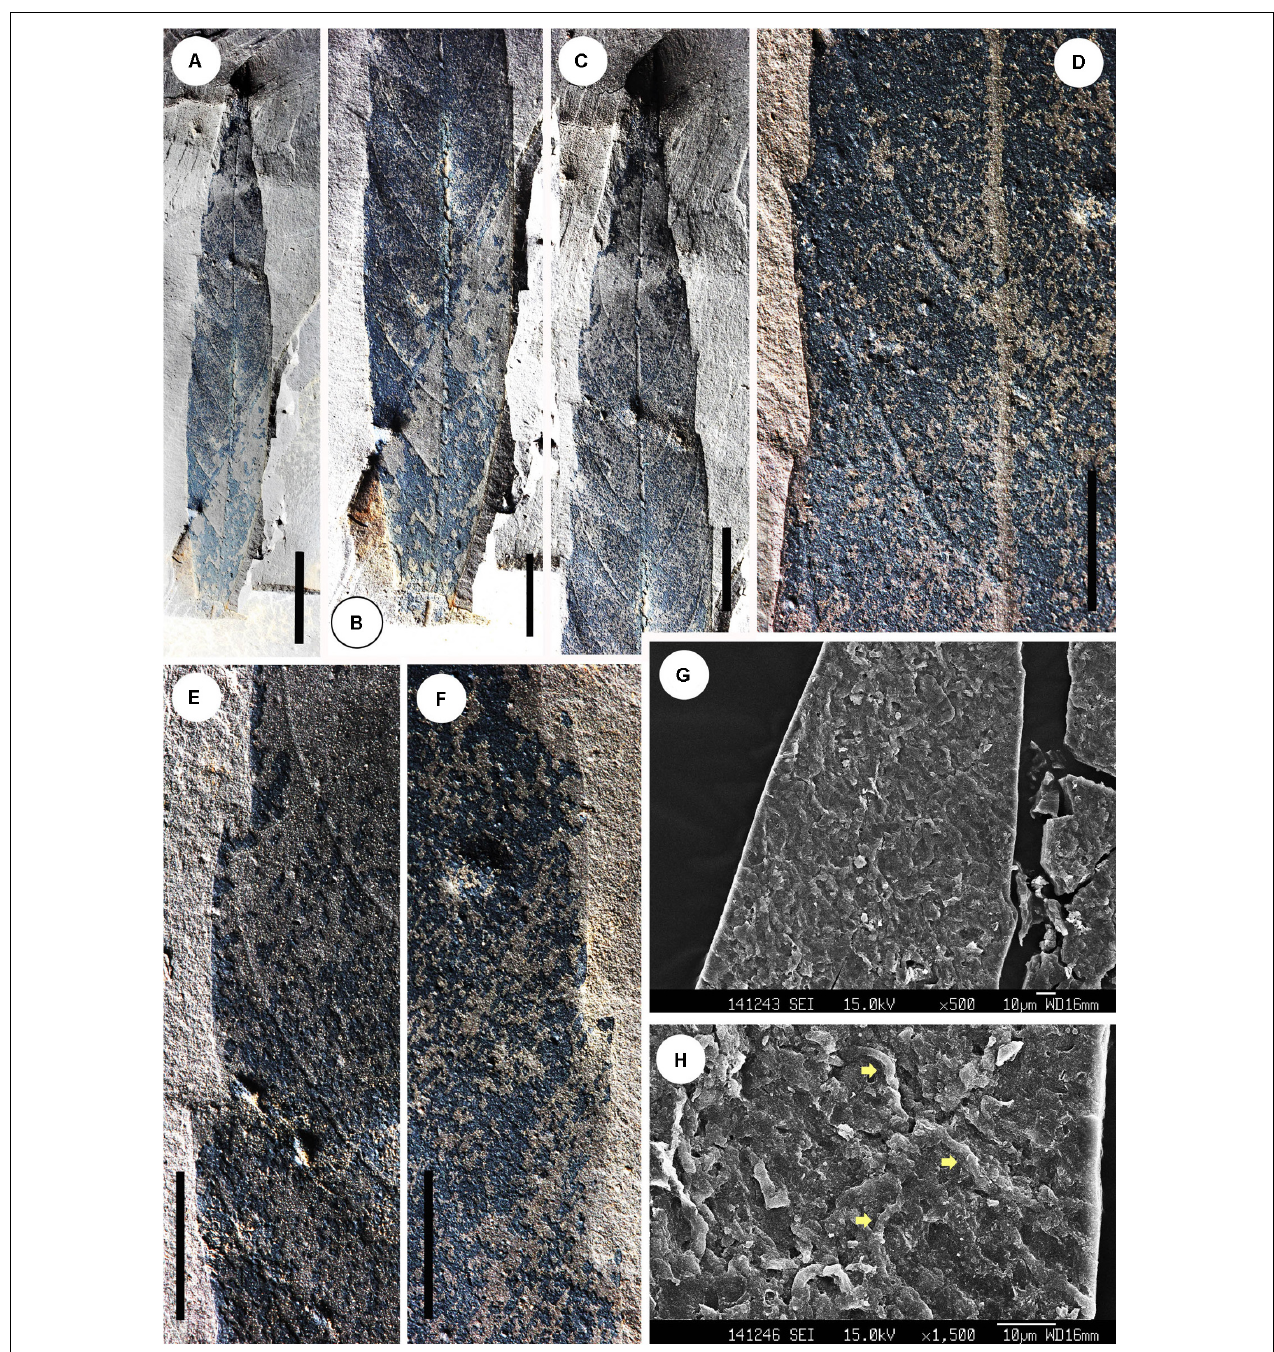
FIGURE 6 | Morphology of Castaneophyllum lanceolata sp. nov. (A) Holotype. Specimen No. CC-1106a, showing leaf morphology; (B) enlargement of (A) , showing the secondary veins from middle to base; (C) enlargement of (A) , showing the secondary veins from middle to apex; (D) enlargement of (A) , showing the teeth; (E) enlargement of (A) , showing the secondary veins end to the margin; (F) enlargement of (A) , showing the tertiary veins; (G) SEM showing rugose outer surface; (H) yellow arrows indicate solitary trichomes. Scale bars: 10 mm (A–C) ; 5 mm (D–F) .